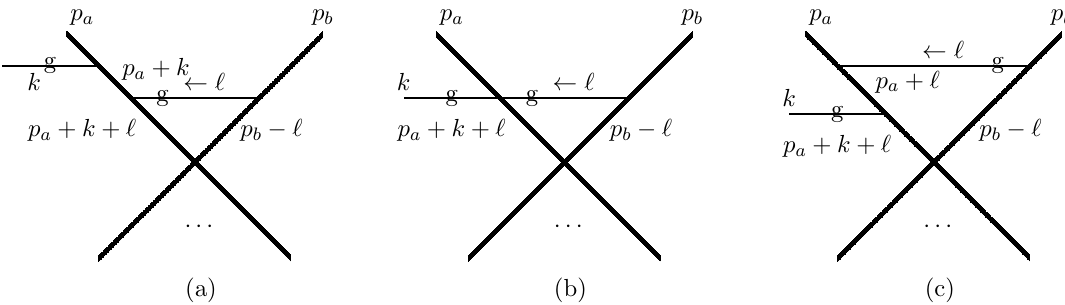
Figure 9 . One loop contribution to (cid:0) ( n; 1) involving internal graviton line connecting two di(cid:11)erent legs. The thicker lines represent scalar particles and the thinner lines represent gravitons.